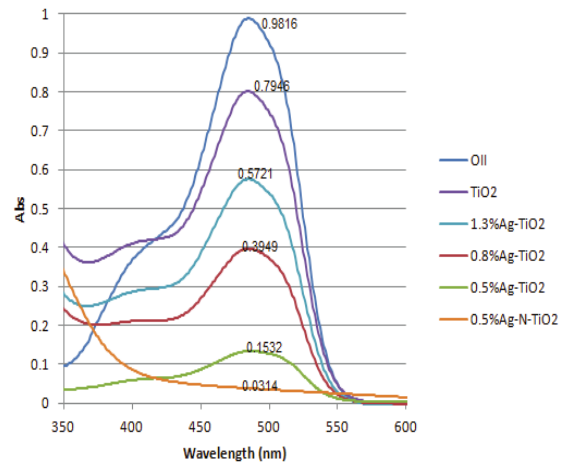
Figure 6: OII dye photocatalytic decomposition under UV exposure in presence of different concentrations of Ag deposited on TiO